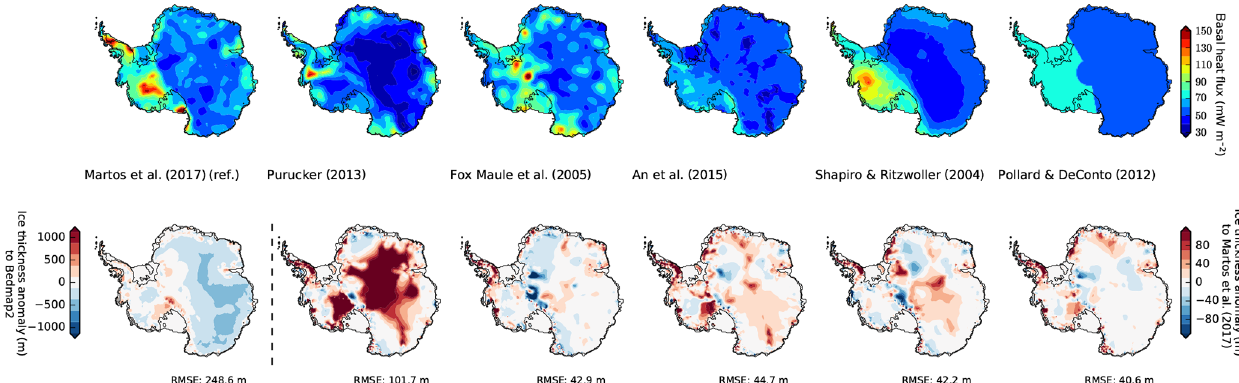
Figure 11. PISM present-day equilibrium results after 50kyr for different basal heat-flux fields (upper row) affecting the near-ground ice temperatures and hence the ice thickness, shown here for the first equilibrium result as anomaly to Bedmap2 (first panel in lower row) or relative to the first result. First three columns show the results for the magnetic reconstructions by Martos et al. (2017) (as in the reference), Purucker (2013) and Fox Maule et al. (2005). Columns 4 to 5 show the seismic reconstructions by An et al. (2015) and Shapiro and Ritzwoller (2004), and last column shows, for comparison, a two-valued field as used in Pollard and DeConto (2012a), separating East and West Antarctica. The overall effect of the choice of geothermal heat flux on present-day equilibrium ice thickness measures up to 100m RMSE for Purucker (2013), while for the other tested set-ups it differs only in individual spots, with a RMSE of